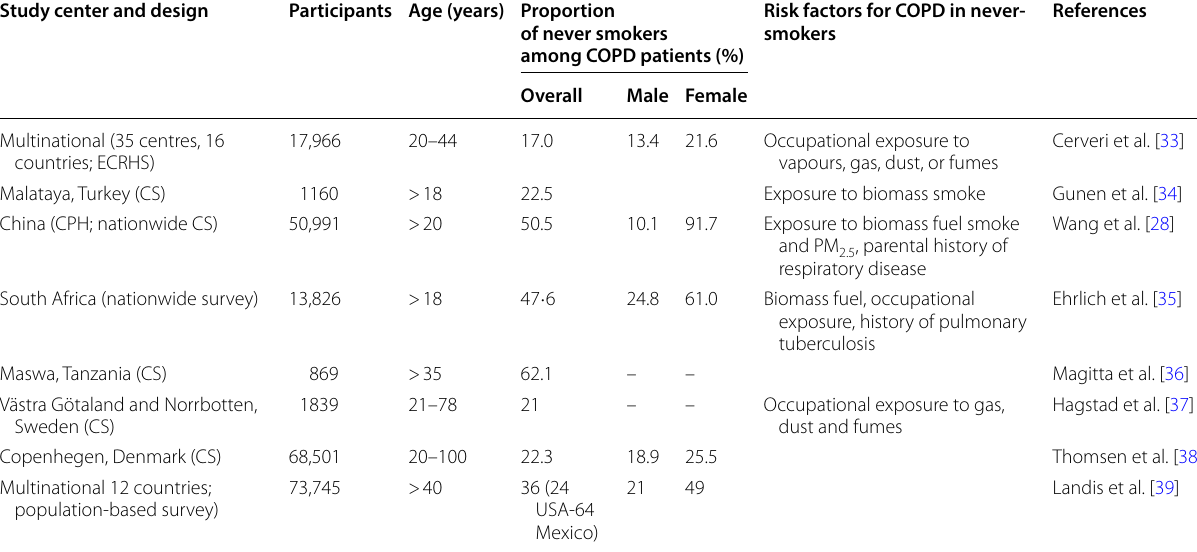
ECRHS European Community Respiratory Health Survey; CS cross-sectional study; CPH China Pulmonary Health; COPD chronic obstructive pulmonary disease